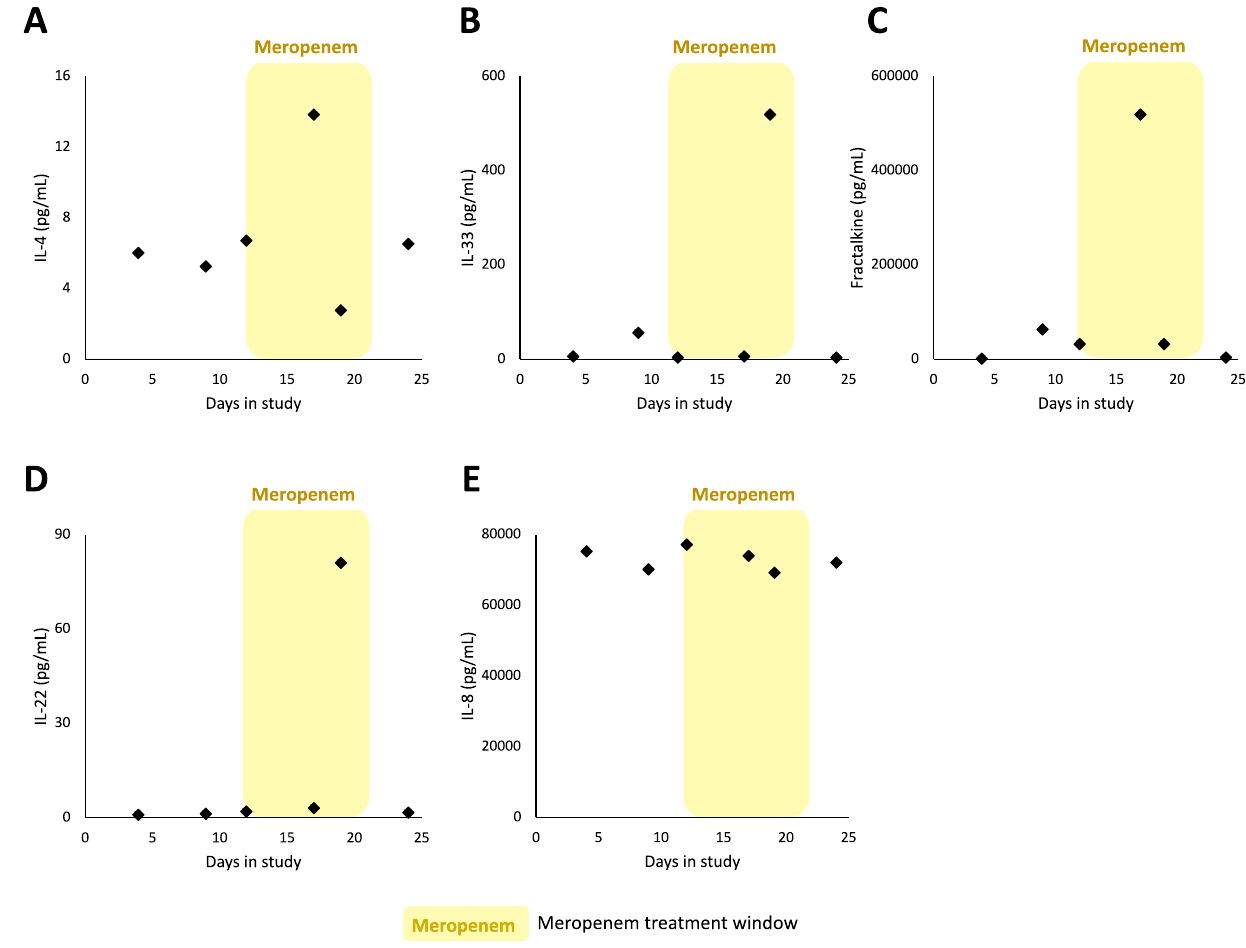
Fig. 3 | Cytokine concentrations were measured in ETA samples collected over the course of the study at days 4, 9, 12, 17, 19 and 24. The following cytokines were measured: A IL-4, B IL-33, C Fractalkine, D IL-22, E IL-8. Yellow shading